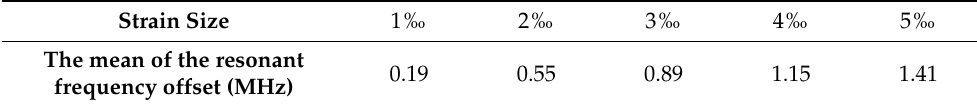
Figure 13. Variation of the resonant frequency of the underlying patch under different strain con-ditions. Table 4. Mean values of the relative offsets at different strain